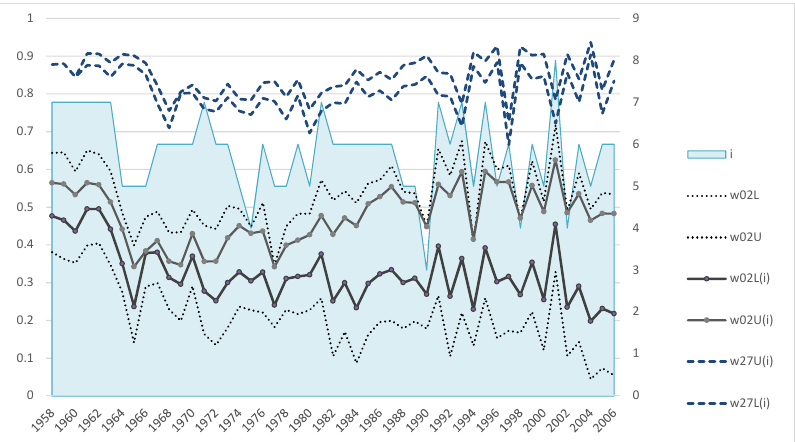
Figure A1. Dynamics of the estimates of juvenile survival rate: initial ( w 02L , w 02U ) and refined ( w 02L( i ) , w 02U( i ) ) after i iterations (number of iterations on the right axis), as well as bounds of the subadults’ survival rate ( w 27L( i ) , w 27U( i ) ).